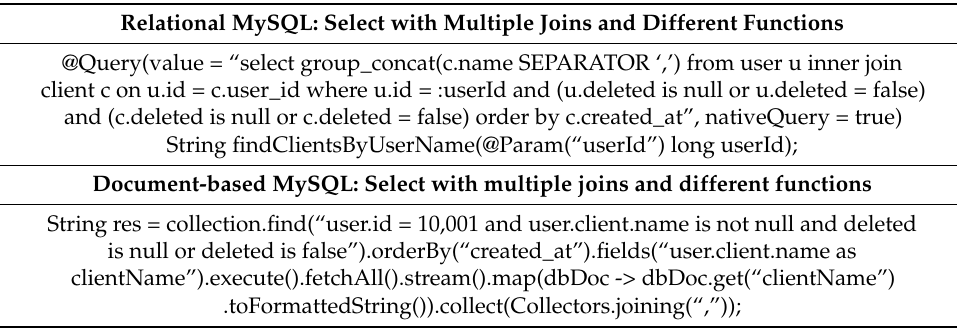
Table 11. Select operation with multiple joins and different